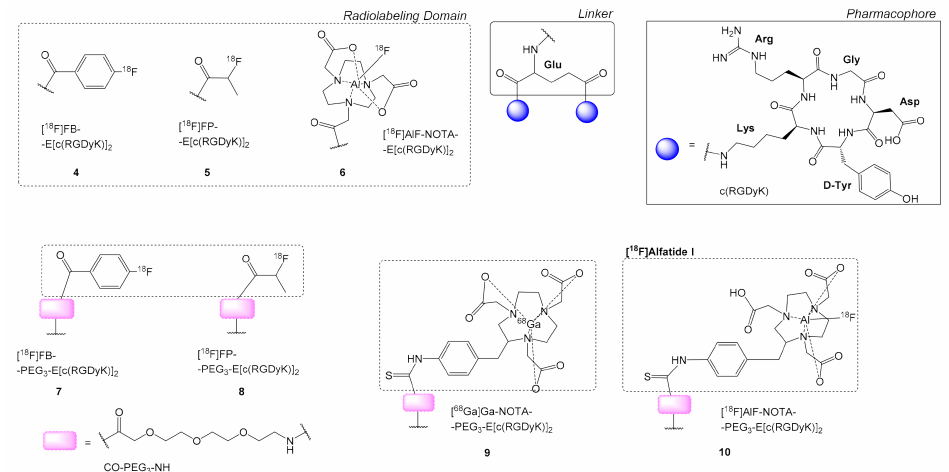
Figure 3. Chemical structures of dimeric radioligands containing the scaffold E(c(RGDyK)] 2 without: [ 18 F]FB-E[c(RGDyK)] 2 4 , and [ 18 F]FP-E[c(RGDyK)] 2 5 , [ 18 F]AlF-NOTA-E[c(RGDyK)]